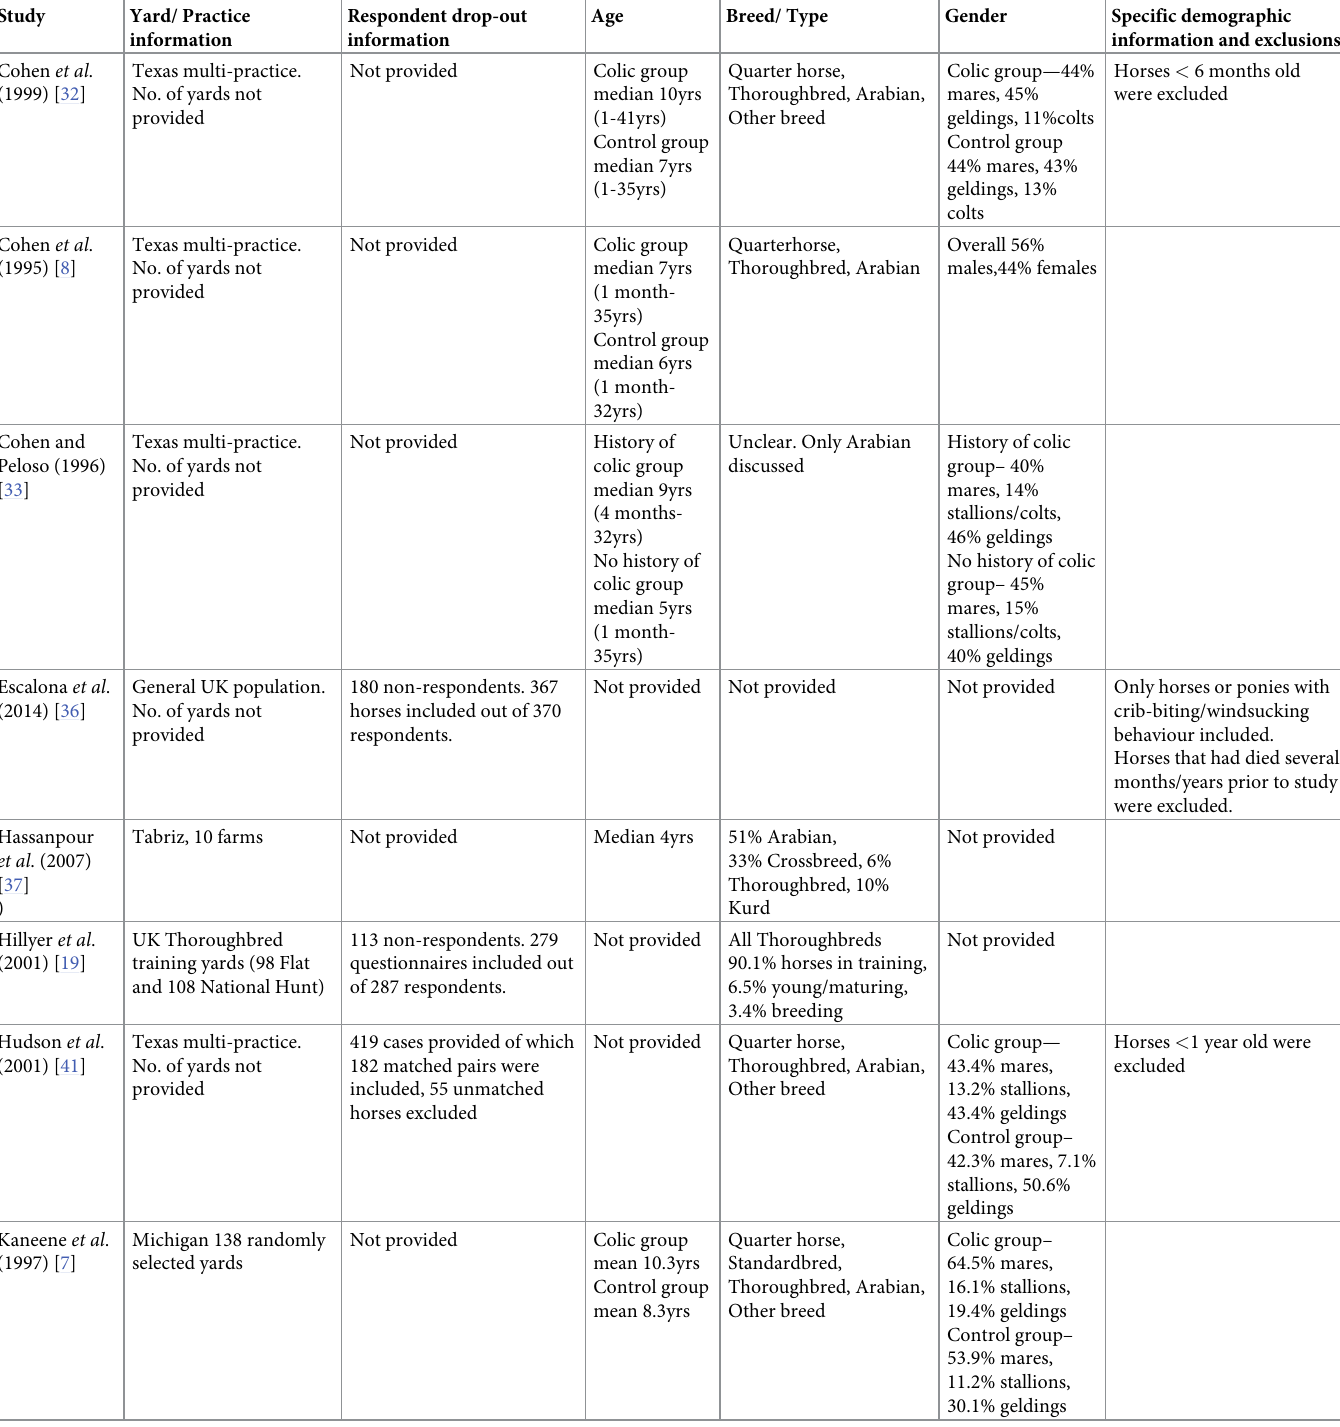
Table 6. Data extraction—Participant characteristics for publications included in a systematic review of management risk factors for colic in the